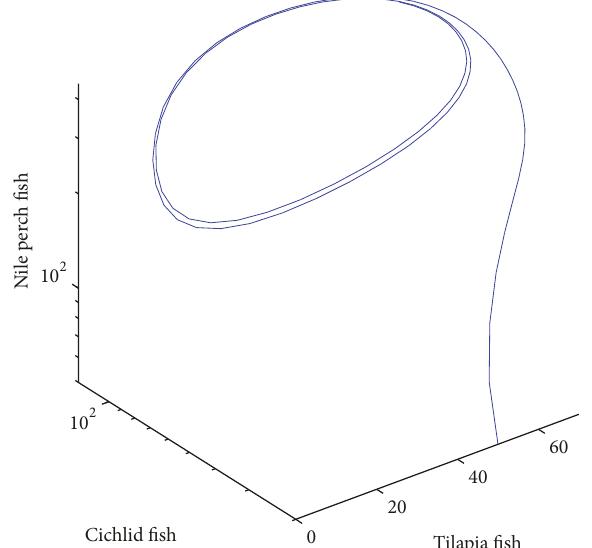
Figure 2: Graph of prey 𝑥 1 and 𝑥 2 and predator 𝑥 3 against time (in years). The limit cycle shows that population density will slightly change but not oscillate the